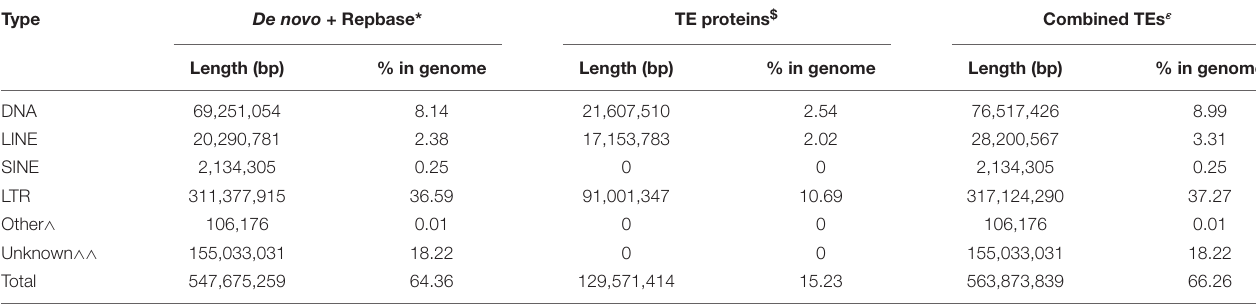
TABLE 2 | Transposable elements content in the reference genome.